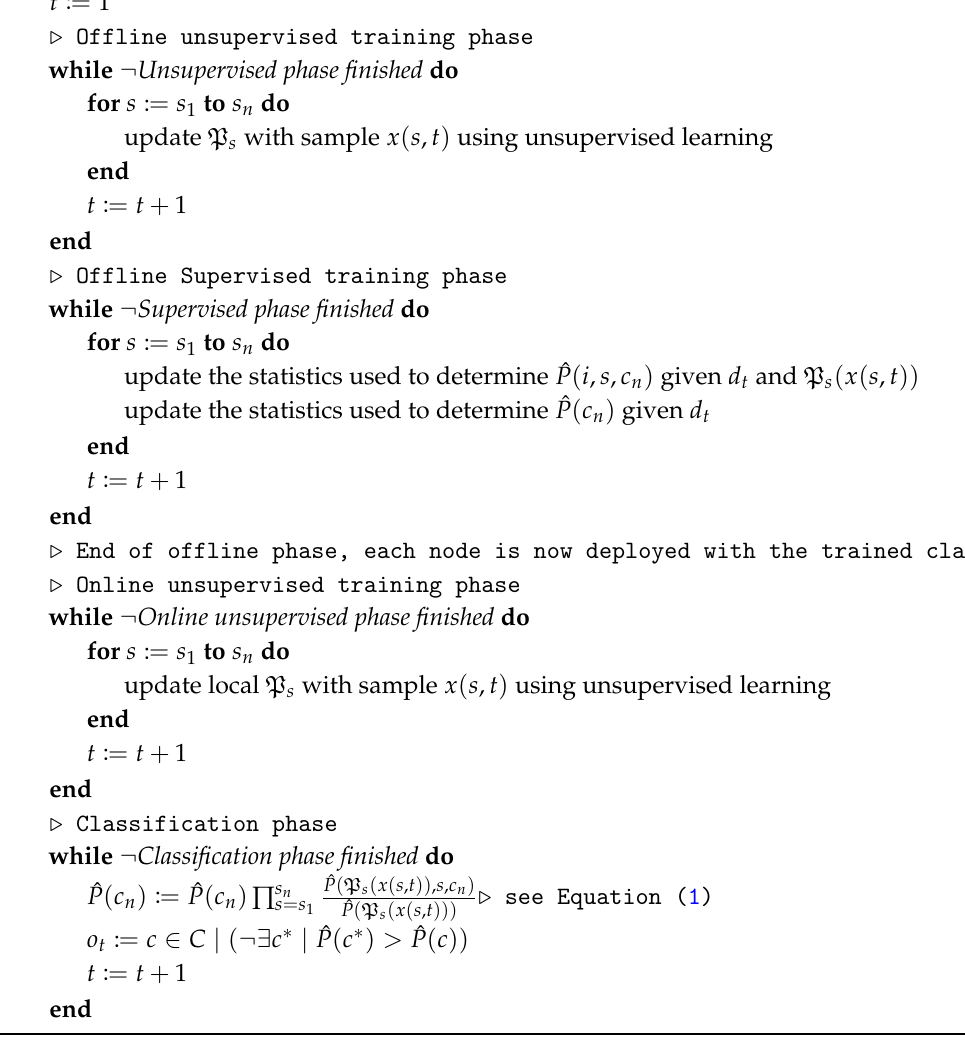
Algorithm 2: QUEST (QUantile Estimation after Supervised Training) updates the unsupervised clustering of the feature space after